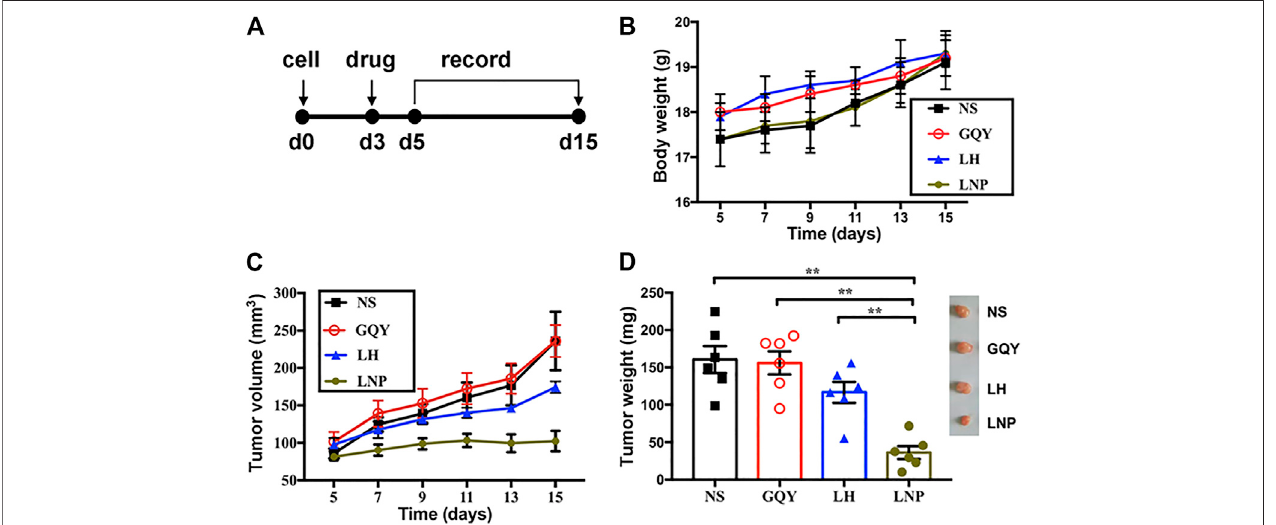
FIGURE 6 | LNPs inhibited tumor development in vivo . (A) different formulations were injected subcutaneously on day 3 after cell injection and the development of solid tumor was monitored. (B) change of body weight of animals during tumor development. (C) change of tumor volume measured during tumor development. (D) weight comparison and representative pictures (right) of harvested tumors from different groups. ** p < 0.01 by one-way ANOVA with Tamhane ’ s T2 post-hoc test.